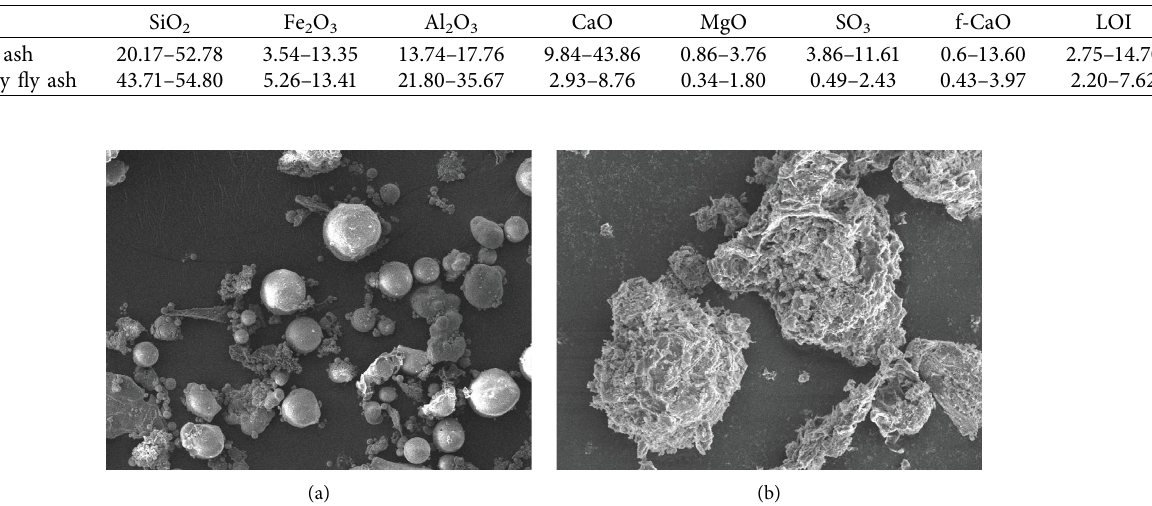
Table 1: Chemical composition of CFB fy ash and common fy ash (%)